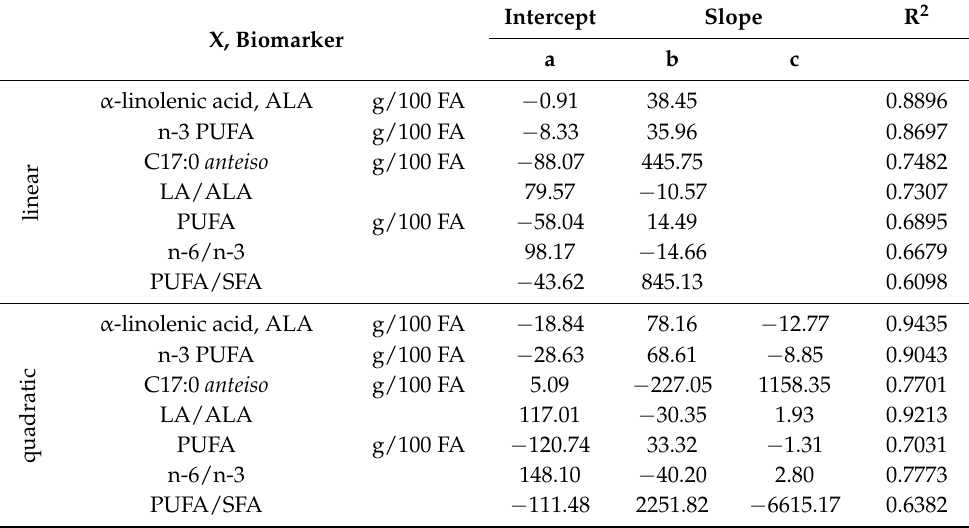
Table 6. Significant ( p < 0.0001) linear (Y = a + bX) and quadratic (Y = a + bX + cX2) regressions of fresh forage intake (Y, % diet DM) to the level of potential biomarkers of cheese (X) to discriminate animal’s feeding regime (R2 >